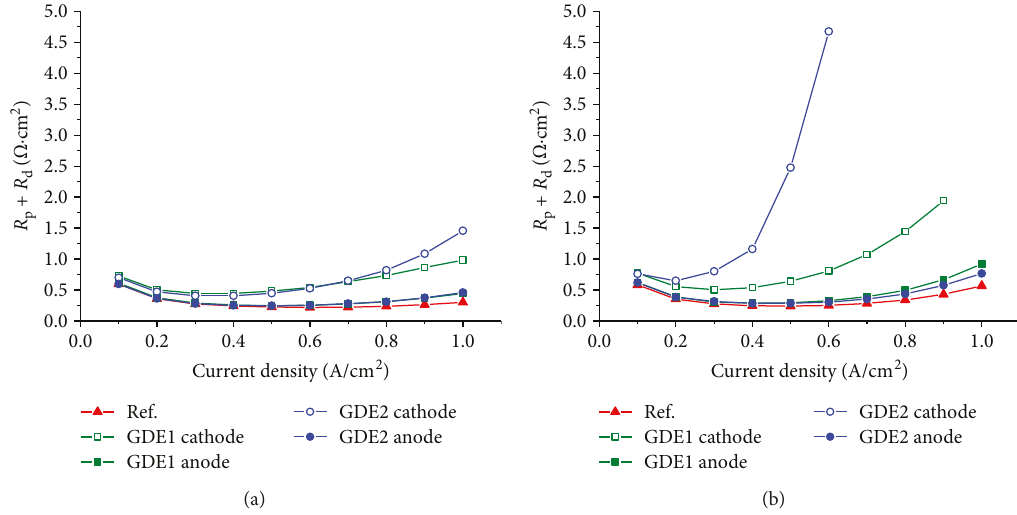
Figure 8: Sum of the charge transfer ( R low inlet gas fl ow rate (b) — 0.2/1 Nl/min H